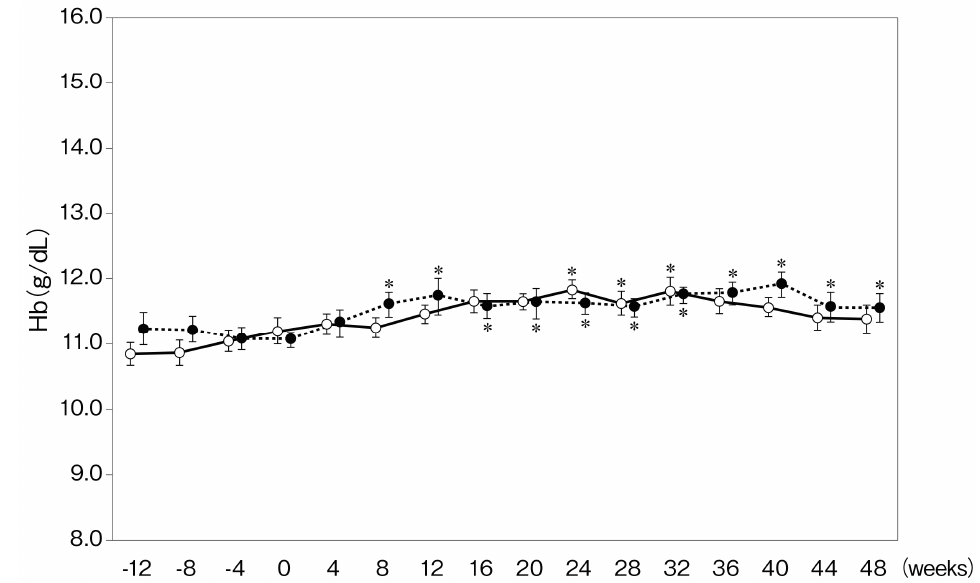
Figure 1. Change in hemoglobin (Hb) concentration. Solid line, darbepoetin α continuation group; dotted line, continuous erythropoietin receptor activator. * p < 0.05 vs. week 0 in each group.